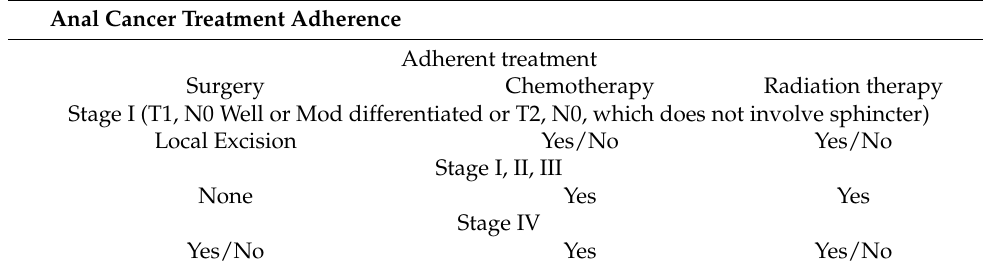
Table 1. Definition of NCCN guideline–adherent